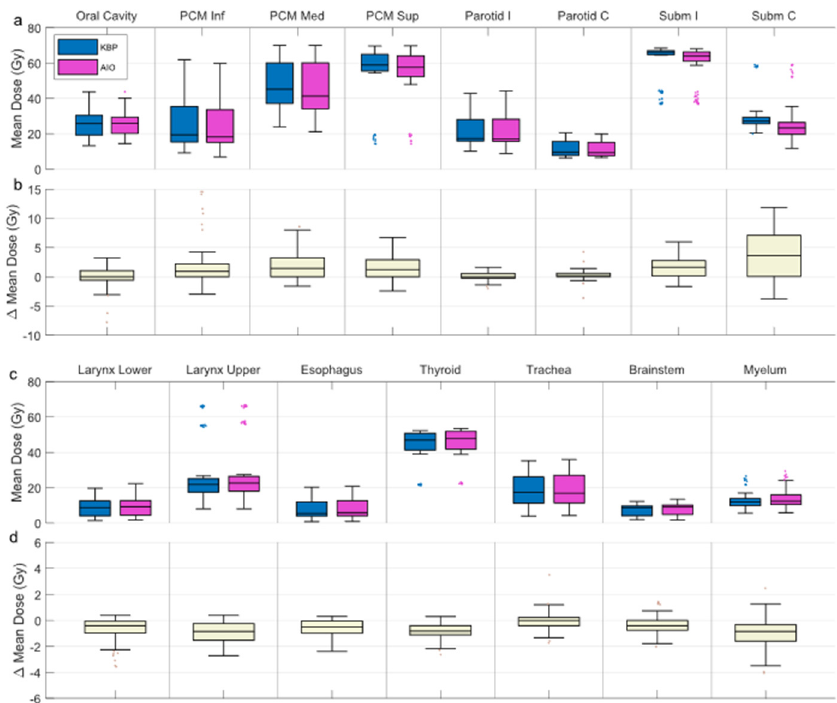
Figure 5. Difference in NTCP Σ ( a ), NTCP Σ and HI ( b ), and individual NTCP grade 2 and 3 endpoints ( c , d ) between RP ‐ and AIO ‐ produced KBPs (RP minus AIO). The upper right quadrant of scatter plots indicates that both endpoints are superior in AIO plans. RP = Rapid Plan ‐ generated plan; AIO = automatic iterative optimizer ‐ generated plan; ∆ NTCP Σ = difference in the sum of grade 2 normal tissue complication probabilities.